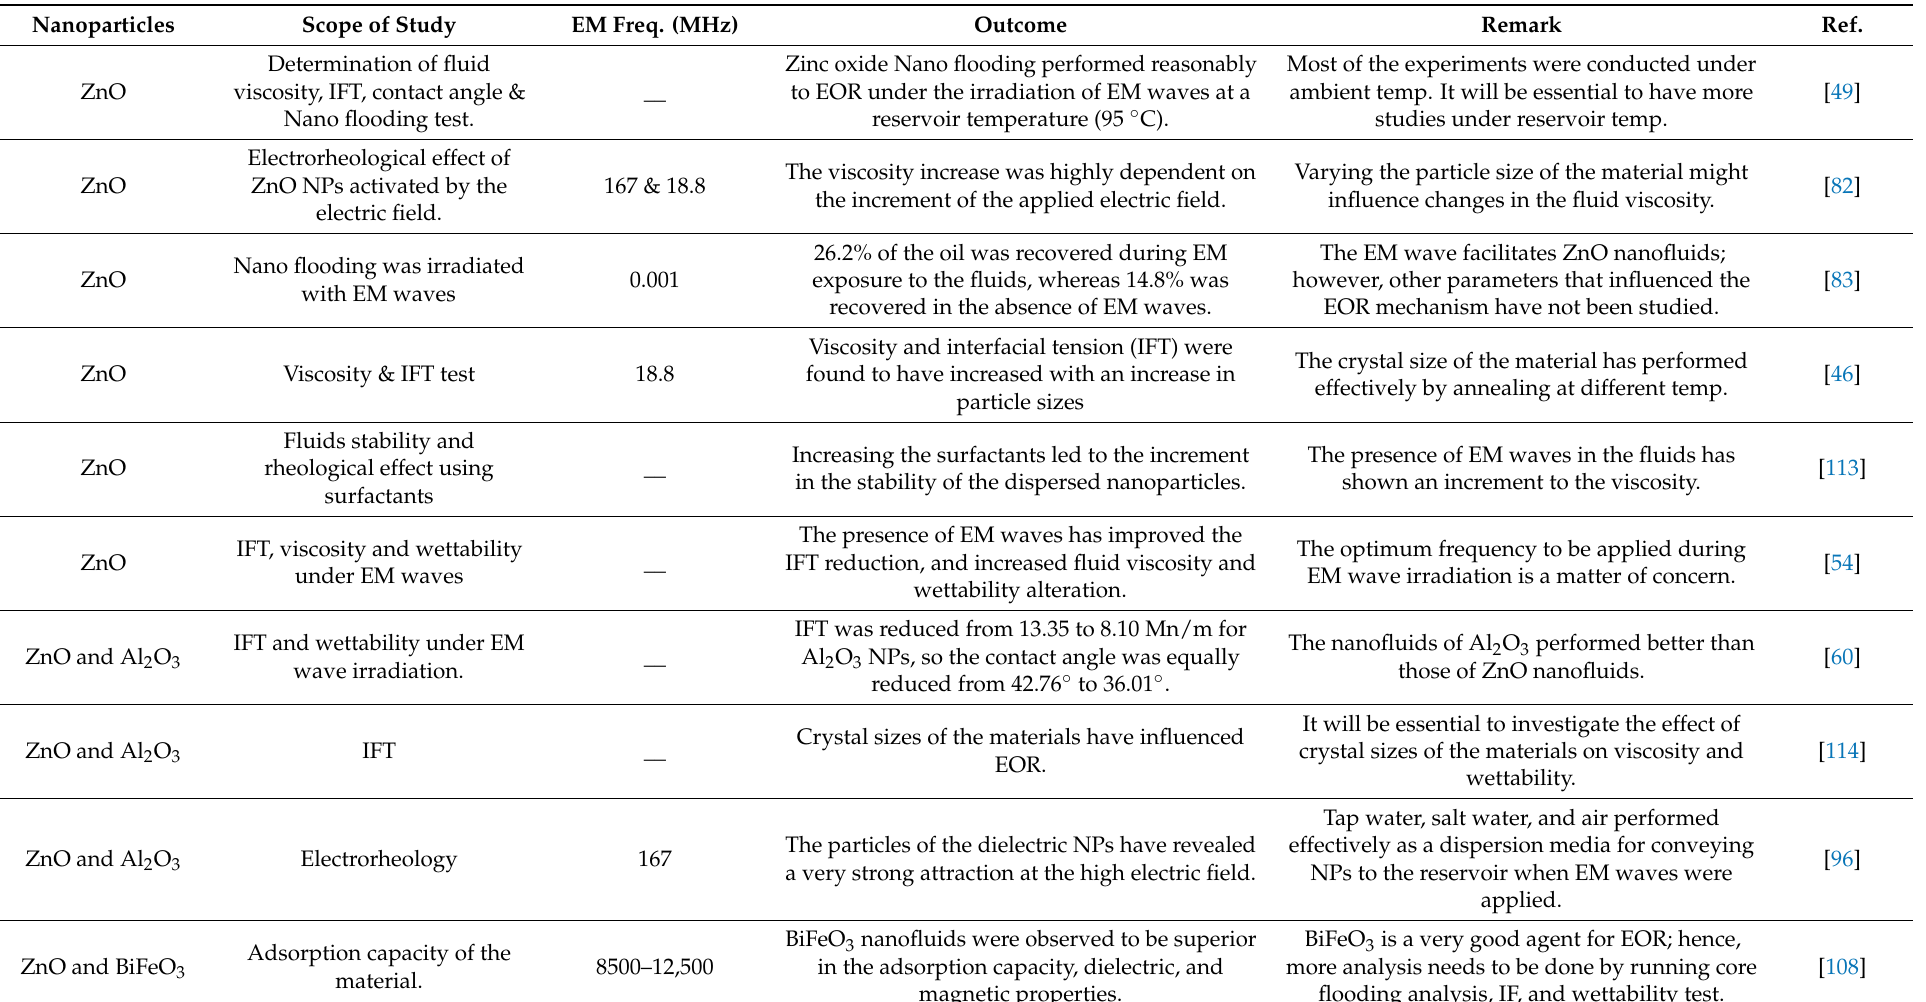
Table 3. Overview of the experimental analysis for the magnetic and dielectric nanofluids for EM-assisted enhanced oil